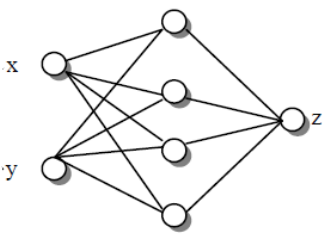
Figure 1: Network Perceptron with a Hidden Layer for the Interpolation Heights